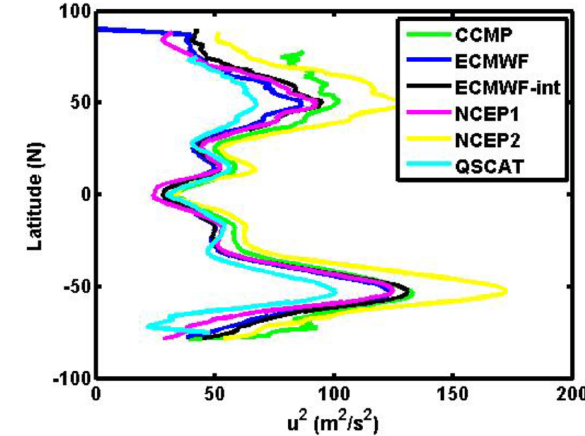
Fig. 5. Comparison of the zonal mean distribution of the second moment of ocean surface winds for the year 2000 for several global wind products. Differences of up to 30m 2 s − 2 (wind speed differ- ence ≈ 4ms − 1 ) are observed, and the biases are not always con- sistent between high and low latitudes. CCMP = Cross Calibrated Multi-Platform winds (Atlas et al., 2011); ECWMF = European Center for Medium Weather Forecasting; NCEP = National Center for Environmental Prediction; QSCAT = QuikSCAT polar orbiting satellite with an 1800km wide measurement swath on the earth’s surface equipped with the microwave scatterometer